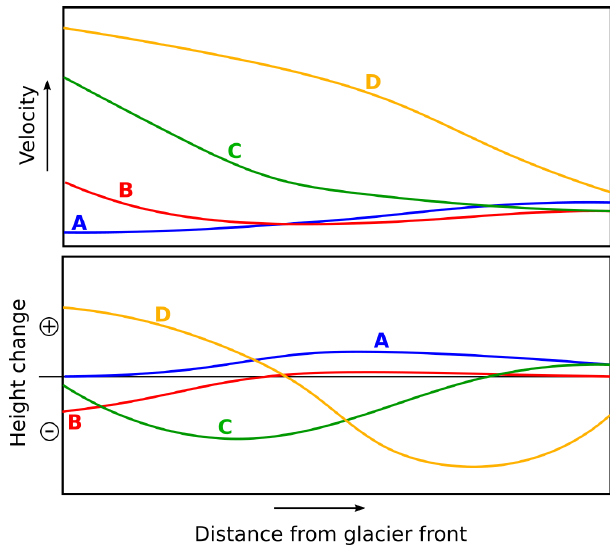
Figure 16. Schematic representation of the velocity and the corre- sponding dynamic ice-height changes for the patterns (A), (B), (C) and